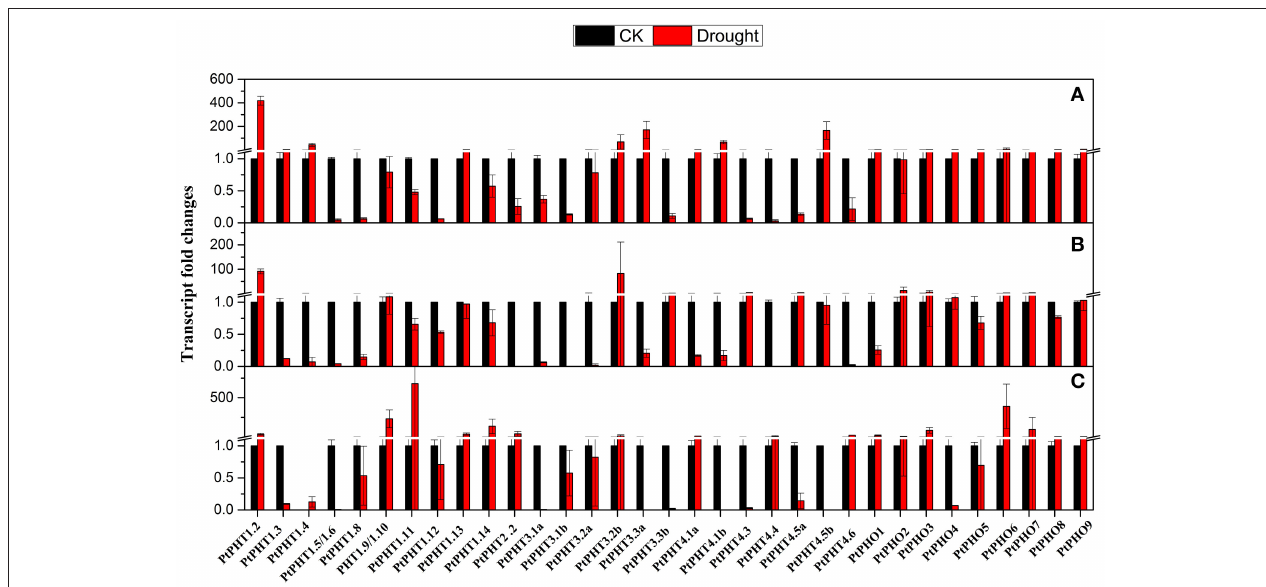
FIGURE 7 | The expression of PHT genes affected by drought at different phosphate levels (A: No P; B: low P; C: high P) in roots of P. simonii seedlings. The control is defined as 1 in the figures. Total RNA was isolated using a plant RNA extraction kit (R6827, Omega Bio-Tek, GA, USA) according to the manufacturer’s instructions. The RNA was used for qRT-PCR with PHT -specific primers. The signal intensities were calibrated based on a constitutively expressed poplar actin gene ( Brunner et al., 2004b). The data are presented as the mean ± SD of three separate